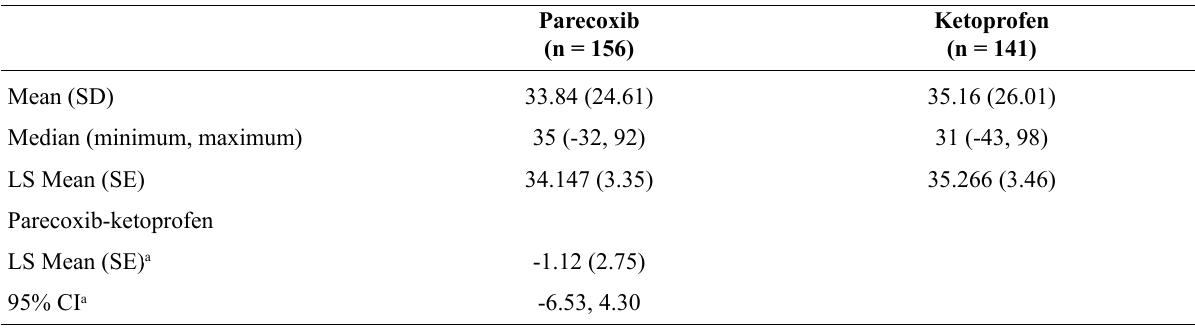
Table 2 - Mean pain intensity difference at minute 30 by VAS (mm) for the PP